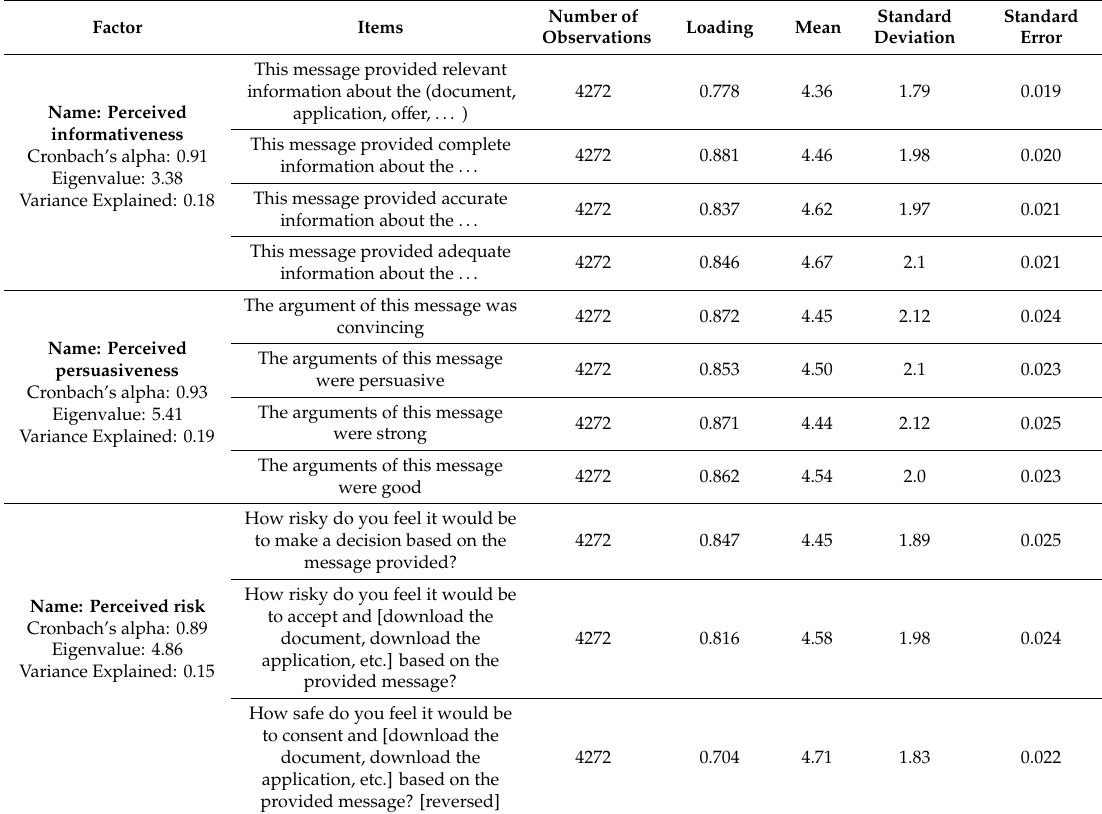
Table 4. Dimensions and item properties.